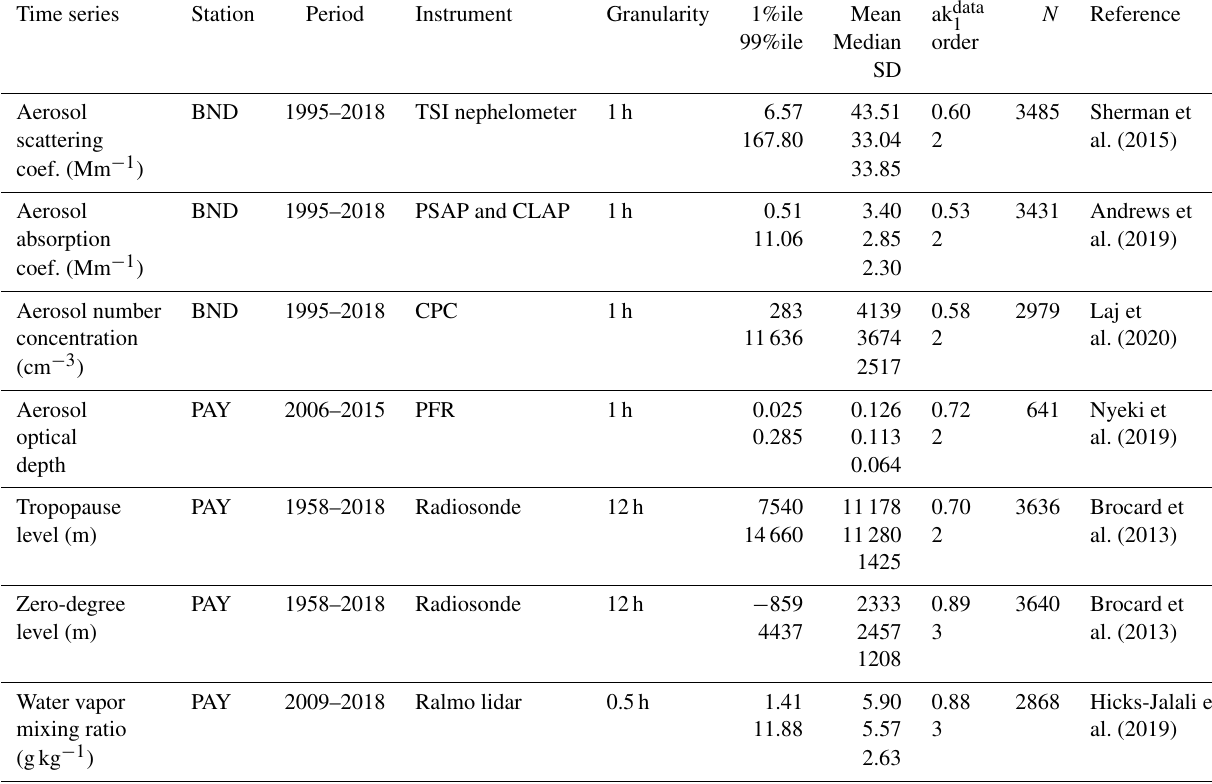
Table 2. Description of the time series: time series with units, monitoring station, period, instrument type, original granularity, ranges (1 and 99 percentiles (1%ile and 99%ile)), mean, median and standard deviation (SD), lag-1 autocorrelation of the observations (ak data of ss partial autocorrelations for the 10-year period (order), number of daily data in the 10-year period ( N ) and